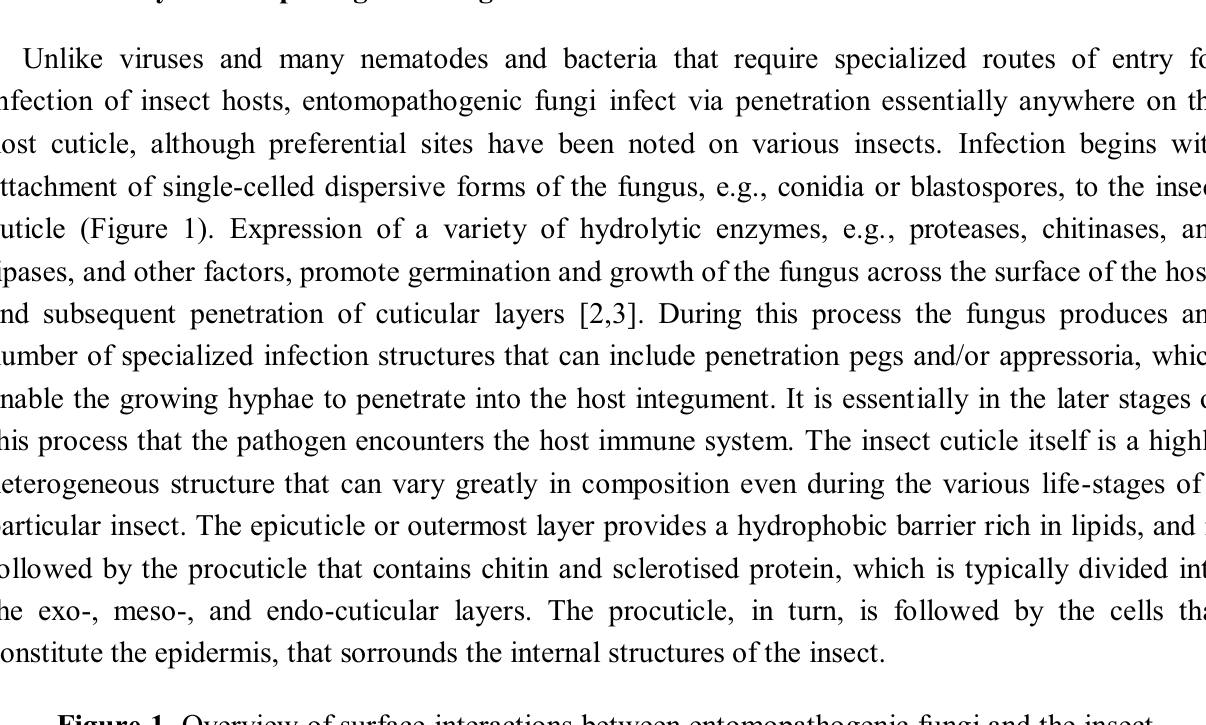
Figure 1. Overview of surface interactions between entomopathogenic fungi and the insect cuticle and host